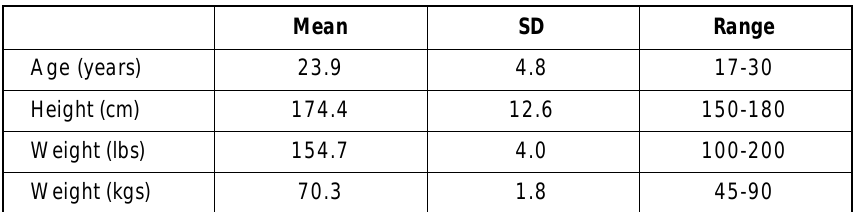
Table 1: Demographic data of subjects